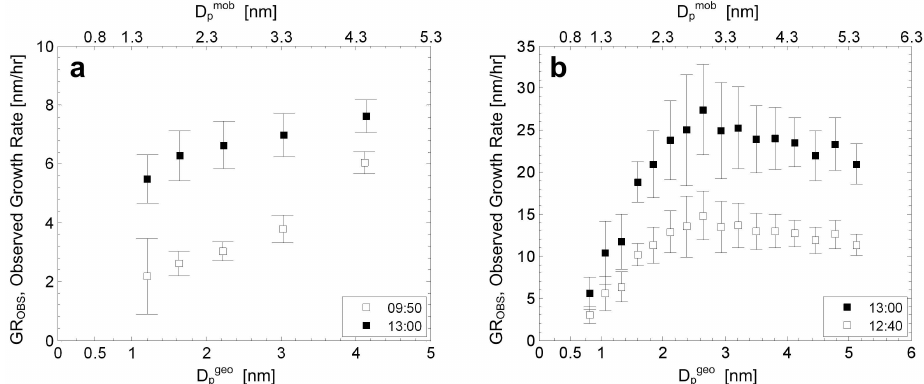
Fig. 1. Observed growth rates and corresponding uncertainties are plotted as functions of particle mobility diameter D mob p (upper abscissa) and geometric diameter D geo p (lower abscissa) for NPF events measured on (a) 7 August 2009 (NCCN), where uncertainties are presented as one standard deviation and on (b) 19 September 2010 (NCAR study), where uncertainties are presented as one standard error, calculated according to Cantrell (2008). Geometric particle diameters were estimated according to Larriba et al. (2011).